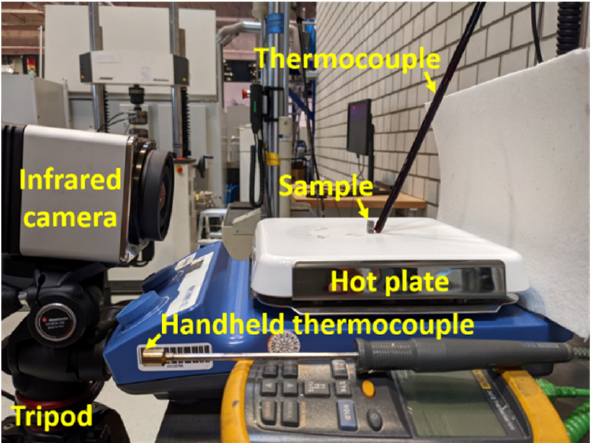
Figure 8. Experimental setup to measure the thermal insulation properties of nested and non-nested cellular solids.